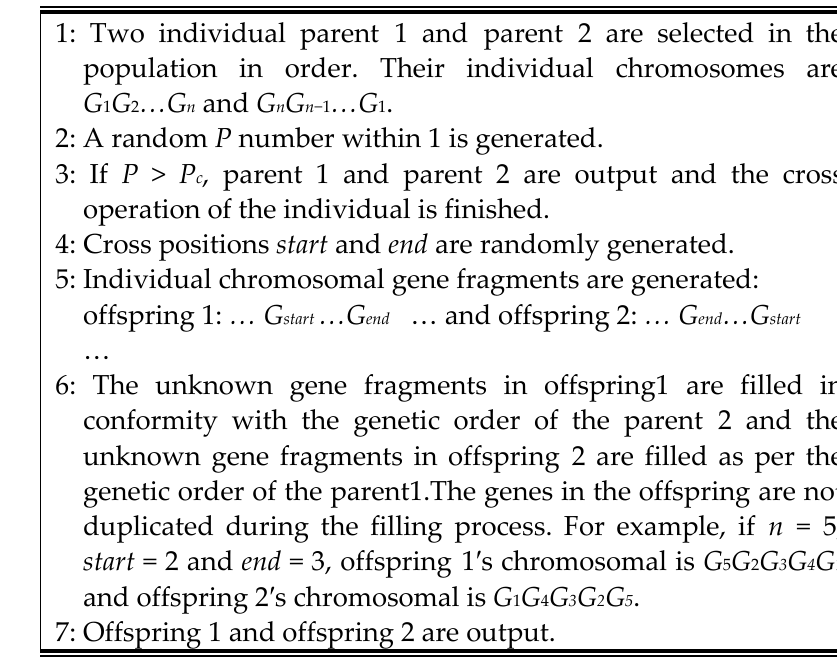
Figure 19. The crossover algorithm.